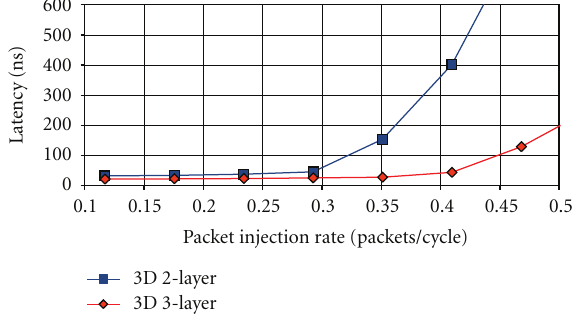
Figure 25: Latency for 2-layer and 3-layer implementations of hp .